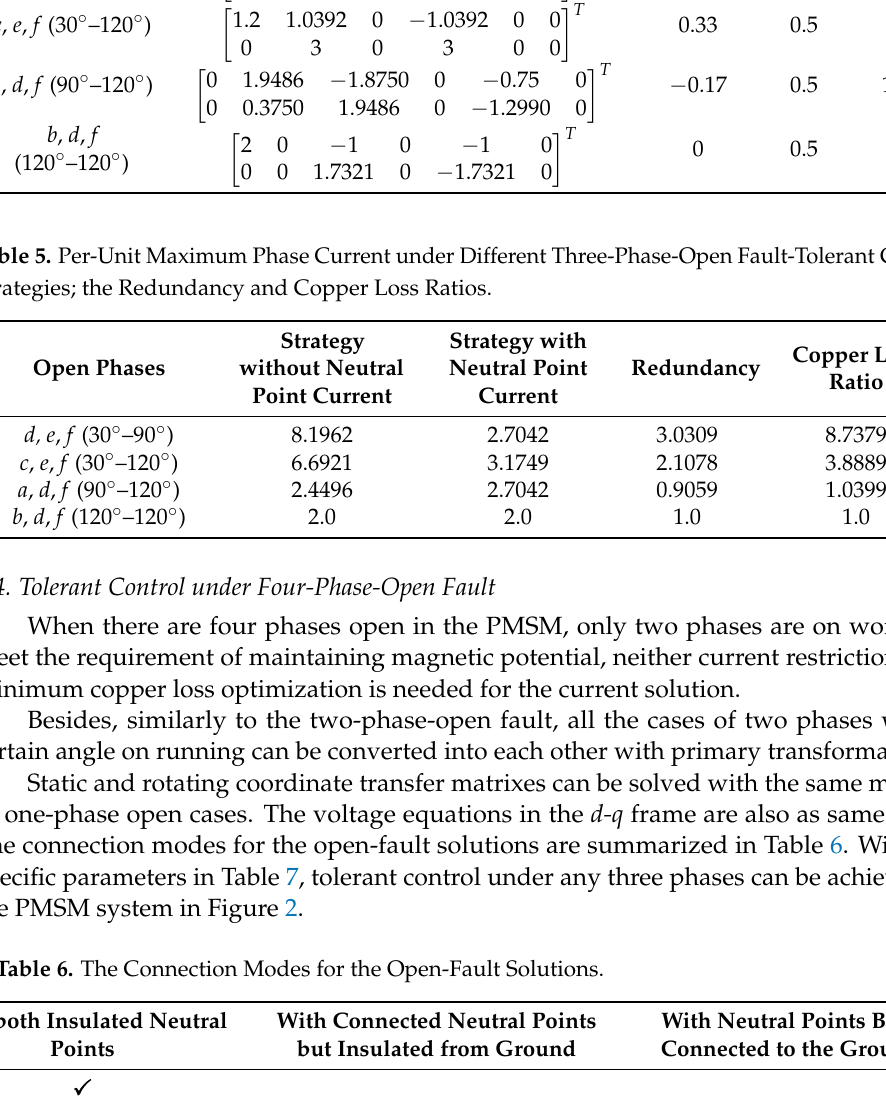
Table 4. Optimum Solutions of Phase Currents and Parameters of Matrix X Under Three-Phase-Open Fault with Neutral Point Current.